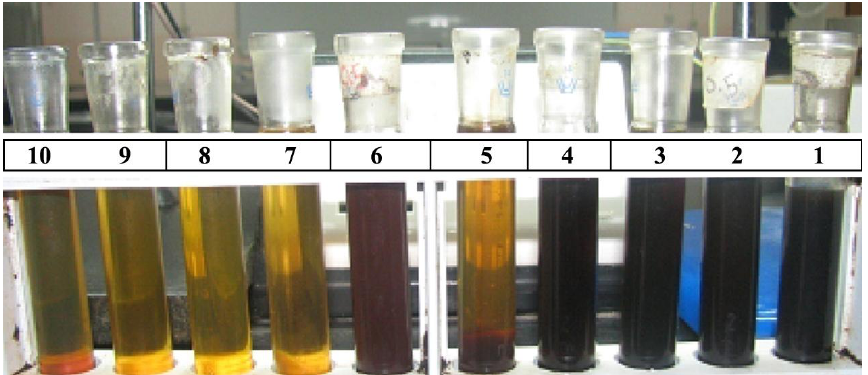
Figure 2. Pictures of the engine oil samples as described in Table